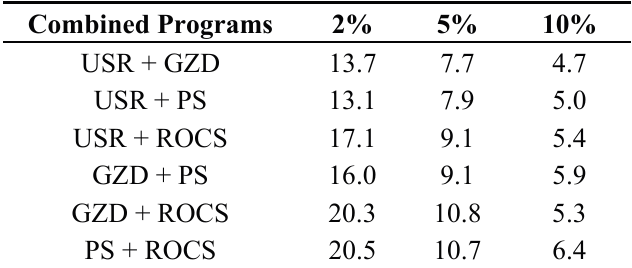
Table 4. Enrichment factors (EF) at 10%, 5%, and 2% for combined